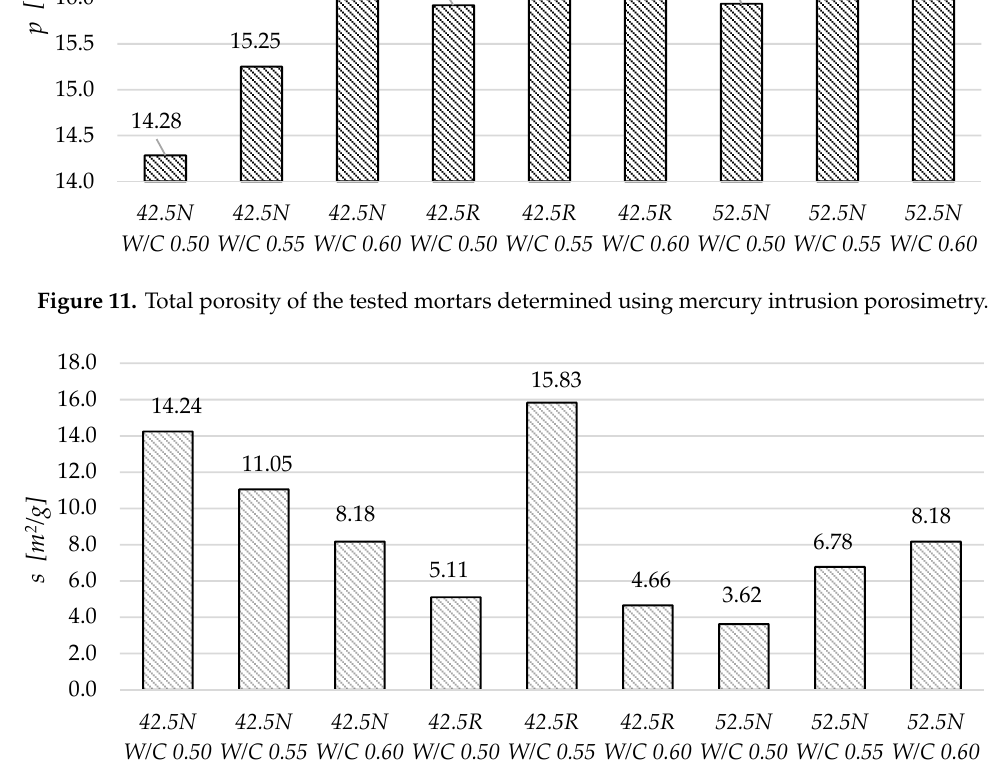
Figure 12. Total surface area of the tested mortars determined using mercury intrusion porosimetry.